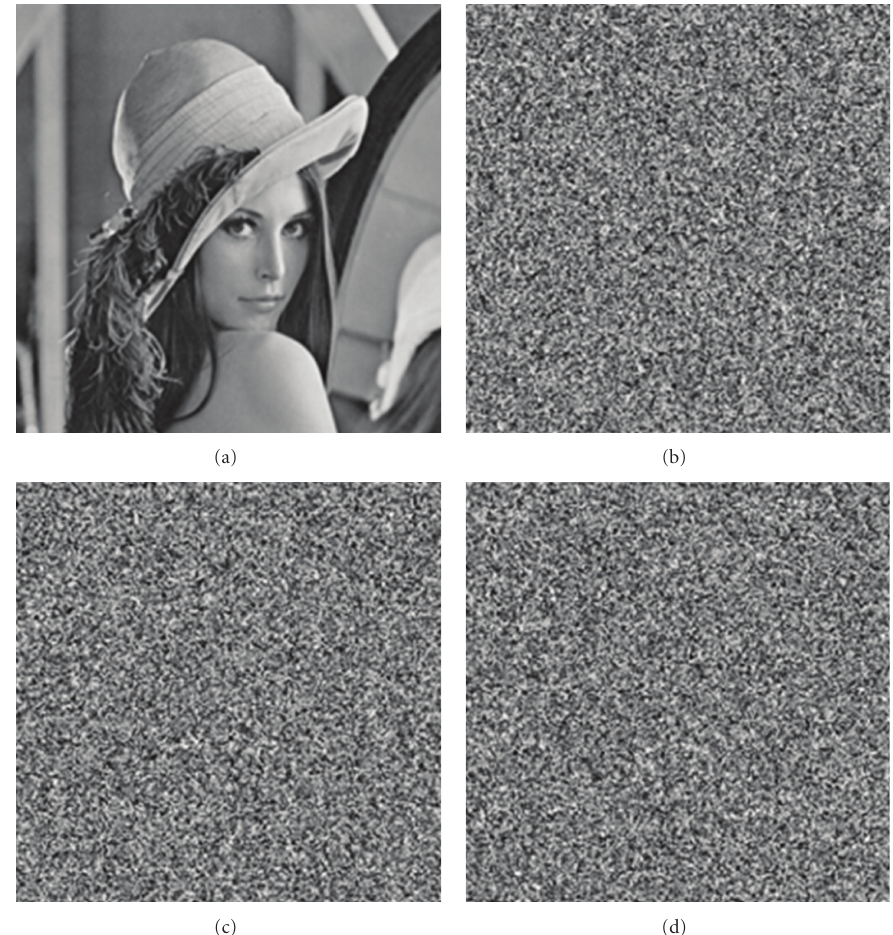
Figure 1: Result of Lena image encryption: (a) the original image, (b) the encrypted image of the described algorithm, (c) the encrypted image of the A5/1 algorithm, (d) the encrypted image of the W7